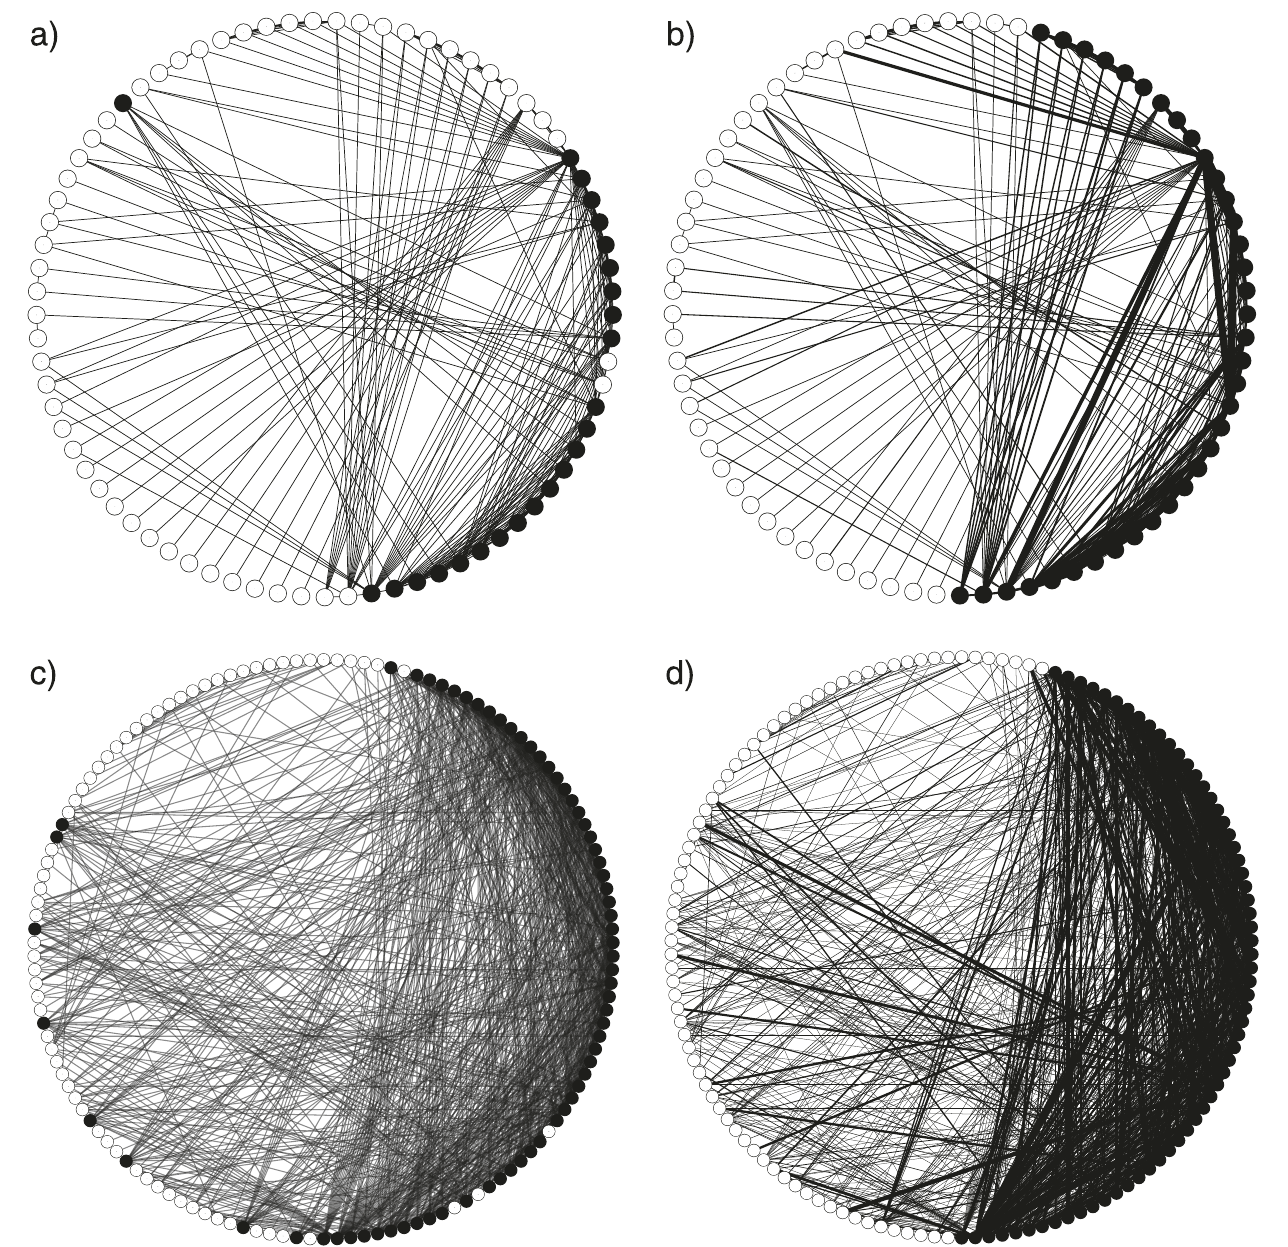
Fig. 9 Bimodular structures detection on real-world social and fi nancial networks. In panels a and b we show the results of the application of our framework for the detection of bimodular structures on the network of co-occurrences of the characters of ‘ Les Miserables ’ 34 (binary case in panel a ; weighted case in panel b ). Link weights re fi ne the picture provided by just considering the presence of links: the core (in black) is, in fact, constituted by the nodes connected by the ‘ heavier ’ links, irrespectively from the link density of the former one. Similarly, panels c and d depict the results of the application of our framework for the detection of bimodular structures on the electronic Italian Interbank Money Market (e-MID) 35 , during the maintenance period approximately corresponding to May 2009 (binary case in panel c ; weighted case in panel d ). As the picture shows, the (purely binary) core links are also the ‘ heavier ’ ones — an evidence con fi rming an ubiquitous tendency in economic and fi nancial systems, i.e. binary and weighted quantities are closely